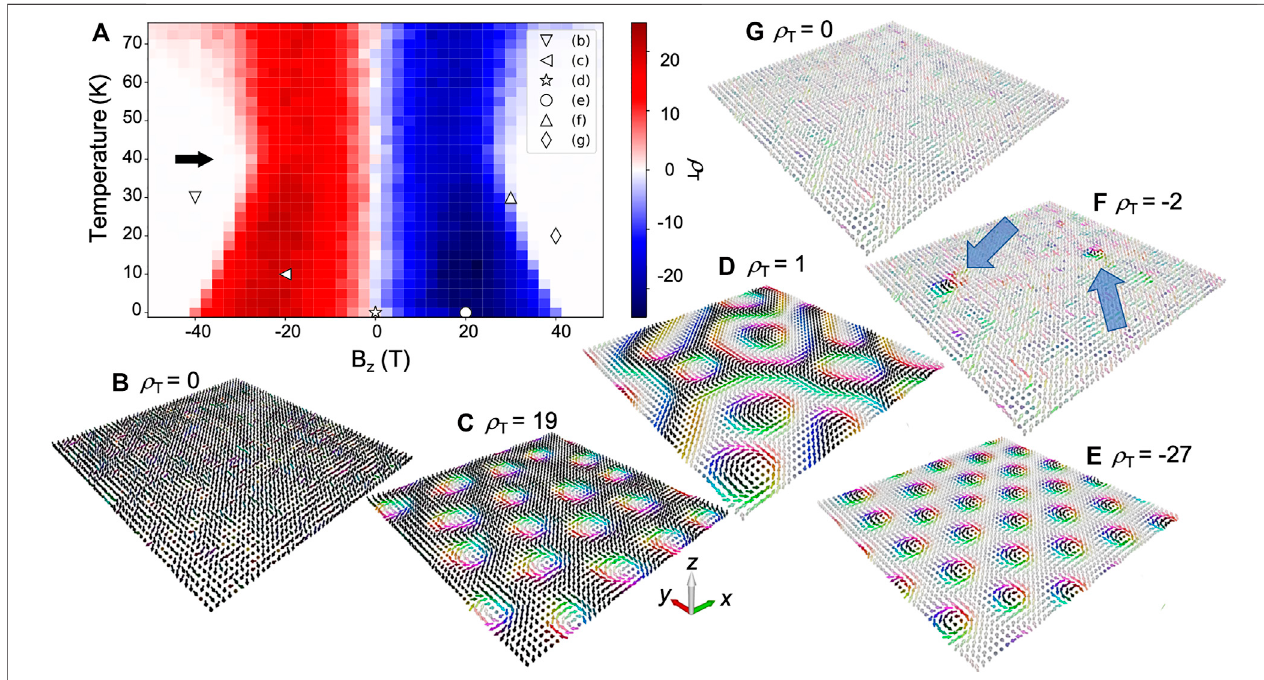
FIGURE 3 | Topologicalchargeofthetoy modeldiscussedinthetext. (A) Dependenceofthetopologicalcharge ρ T ontheexternalmagnetic fi eldandtemperaturecalculated from the fi nal spin texture after an LLG calculation. The black arrow highlights the in fl ection point where | ρ T ( B z )| has a minimum with respect to B z . For the parameters marked by the symbols (B – G) the resulting spin textures are shown in the corresponding panels. The arrows in (F) highlight the two skyrmions that result in a topological charge of ρ T = − 2.